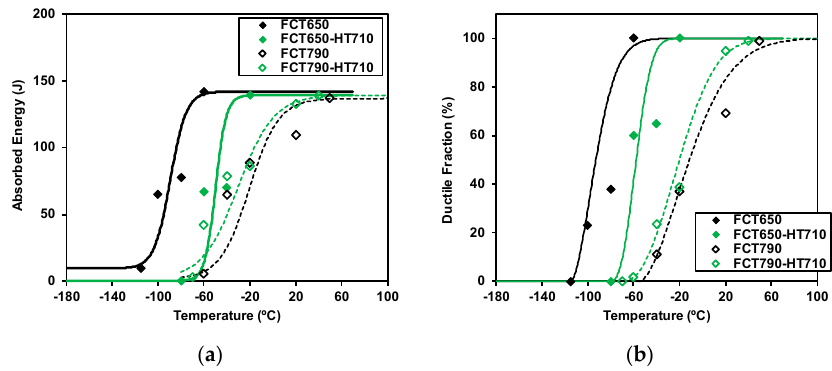
Figure 17. Comparison between Charpy curves corresponding to FCT650, FCT650-HT, FCT790 and FCT790-HT: ( a ) absorbed energy and ( b ) ductile fraction as a function of the test temperature.